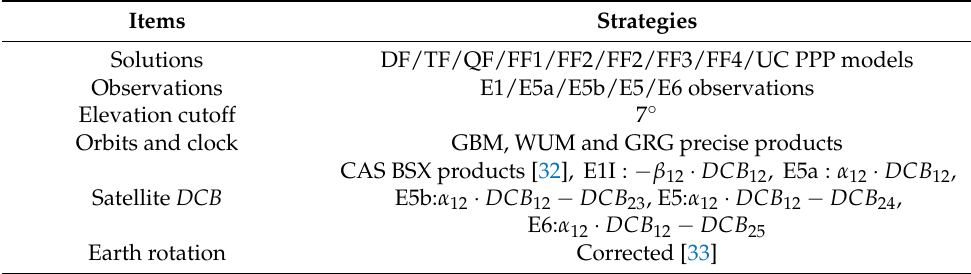
Table 3. Detailed processing